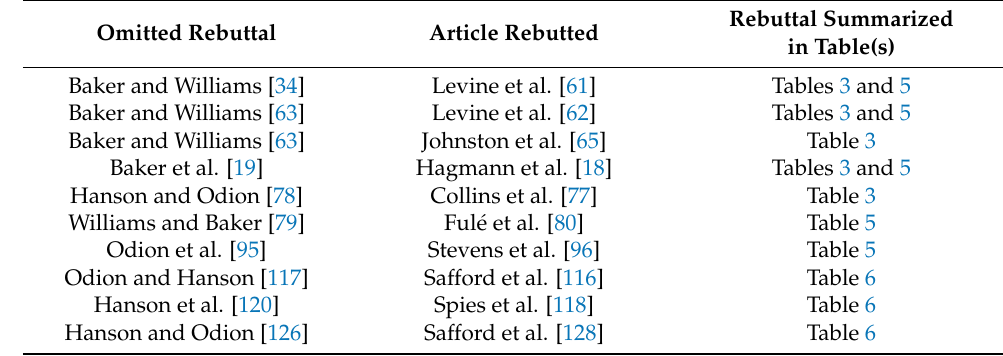
Table 8. Published rebuttals, omitted in H, of ten publications used as evidence in H. Listed are the tables containing a summary of the omitted evidence, which refuted the rebutted articles and H’s conclusions. Details of these rebuttals are in the text.